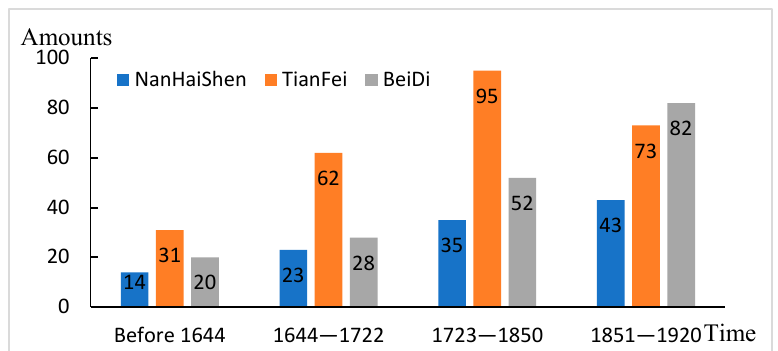
Figure 2. The counts of the Water Deities’ temples in different stages.